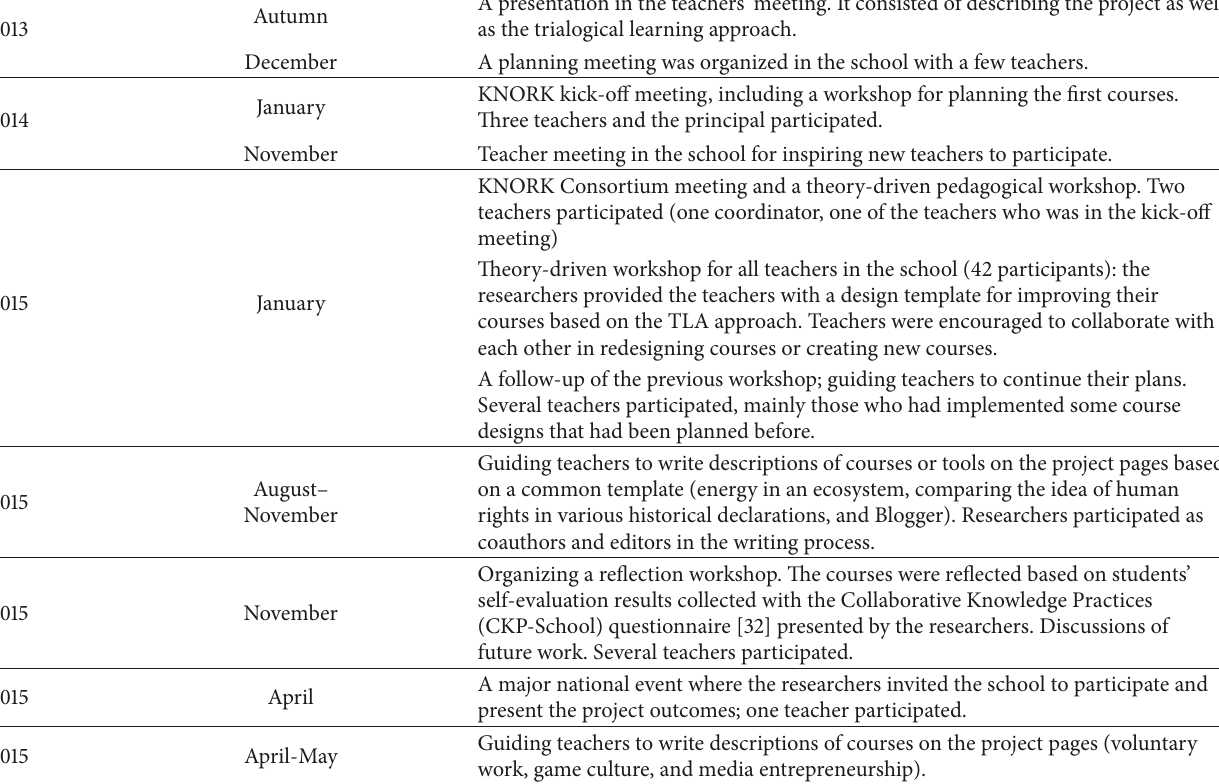
Table 1: Project-related activities during the end of 2013–June 2016.